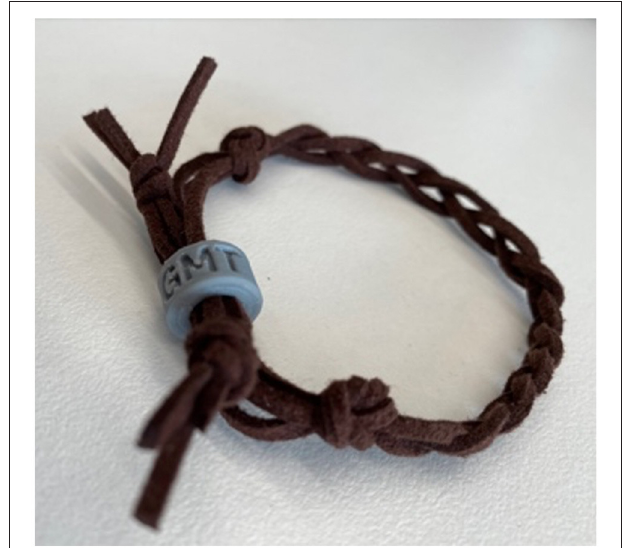
FIGURE 3 | GMT + mindfulness bracelet.